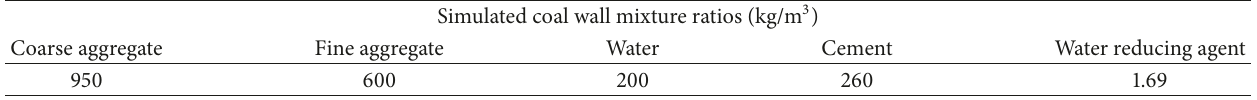
Table 4: Constituent material mixture ratios for simulated composite coal wall.